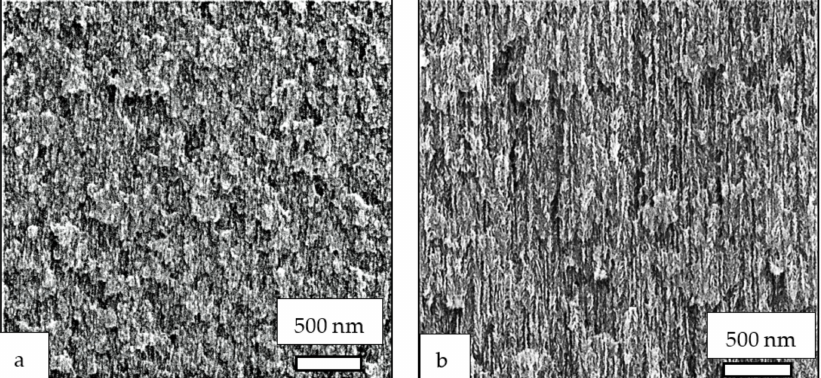
Figure 4. SEM images of cleavage fragments of porous layers of n-type ( a ) and p-type ( b ) silicon wafers after anodic